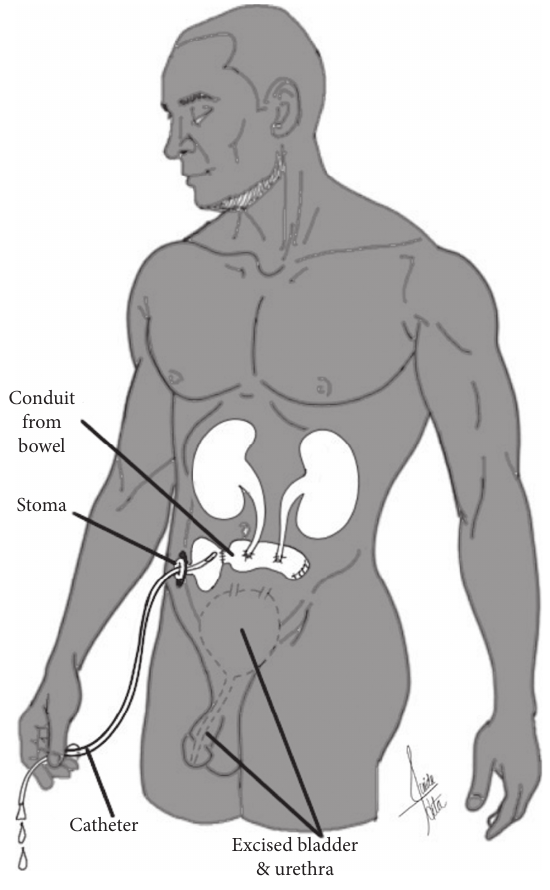
Figure 2: Noncontinent cutaneous diversion. Urine is drained from the ureters to a conduit constructed from the ileum or colon. The conduit is anastomosed to the abdominal skin surface, and urine is collected in an external